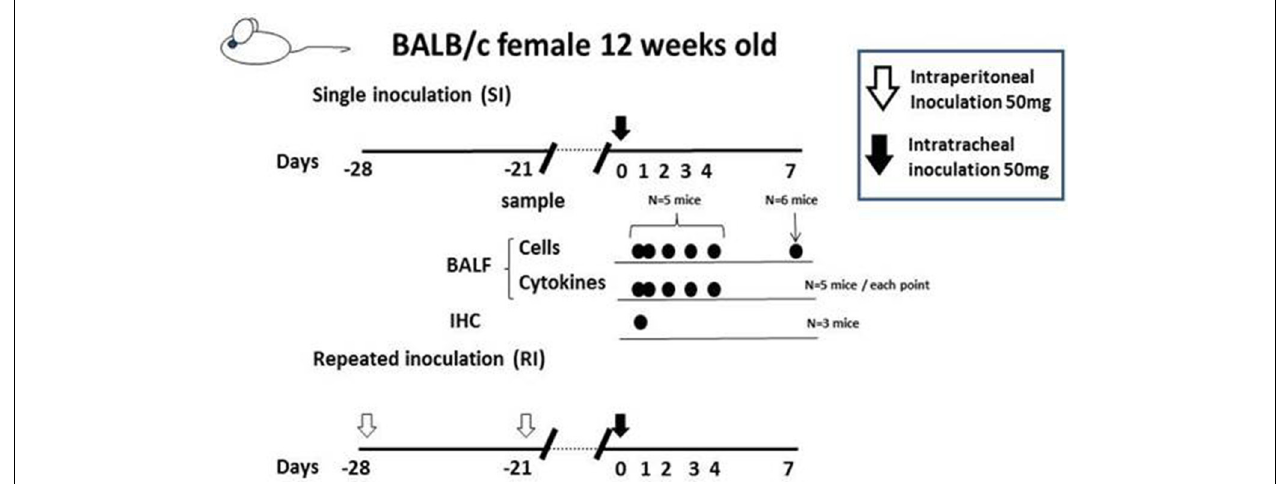
FIGURE 4 | The“noadjuvantused”modelwascreatedbyintraperitoneally immunizing with only Mp antigen twice, on days − 28 and − 21 (for the RI, repeated inoculation, group) or without pre-treatment (for the SI, single